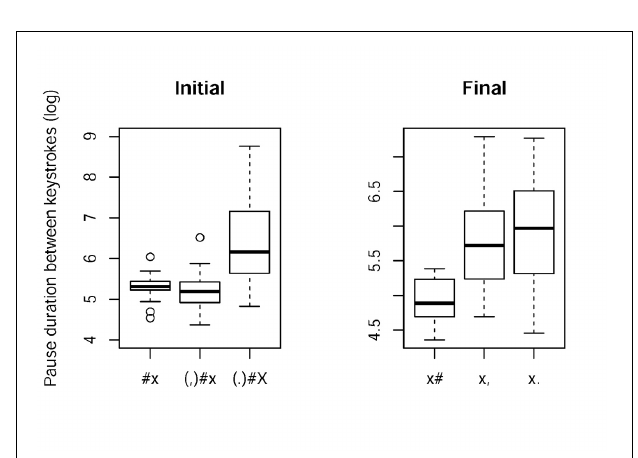
FIGURE 2 | Boxplots for interkey durations corresponding to initial lengthening (left) and final lengthening (right) in writing. Interkey duration was log-transformed. #x = word initial interkey duration, (,)#x = interkey duration after comma, (.)#X = interkey duration after full